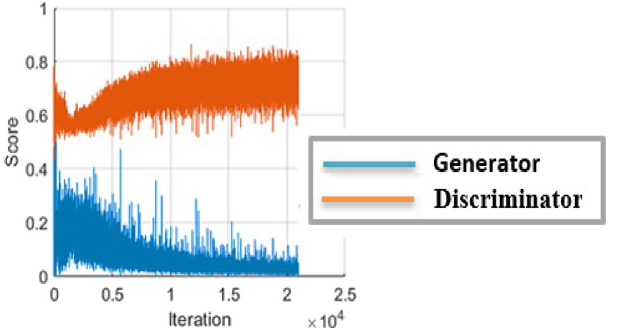
Figure 8. Total loss of the constructed CGAN. G loss decreases when the D loss increases , the two networks play a mina mini-max two-player